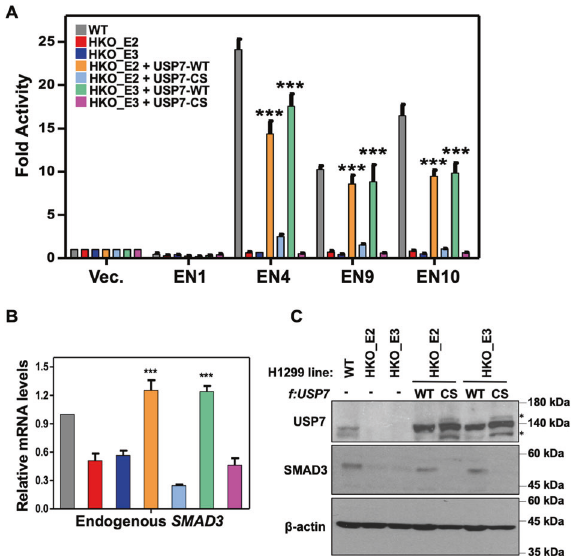
Fig. 5 The deubiquitinase activity of USP7 is required for USP7- mediated transcriptional activation of SMAD3 . A Luciferase reporter assays showing the relative enhancer activities of SMAD3 SE constituents in H1299 wildtype and USP7 KO cells without or with ectopically expressed USP7 wildtype (WT) or deubiquitinase- de fi cient CS mutant. B , C The relative mRNA ( B ) or protein ( C ) levels of endogenous SMAD3 were determined by RT-qPCR or immuno- blotting assays, respectively, in H1299 cells described in ( A ). Mean ± SD from three independent experiments. Student ’ s t -test, *** p < .001. Asterisks indicate nonspeci fi c signals.